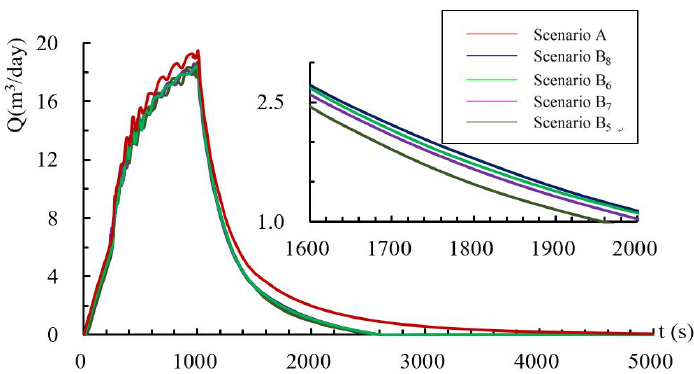
Figure 9. Spring hydrographs with different injection rate at W3.